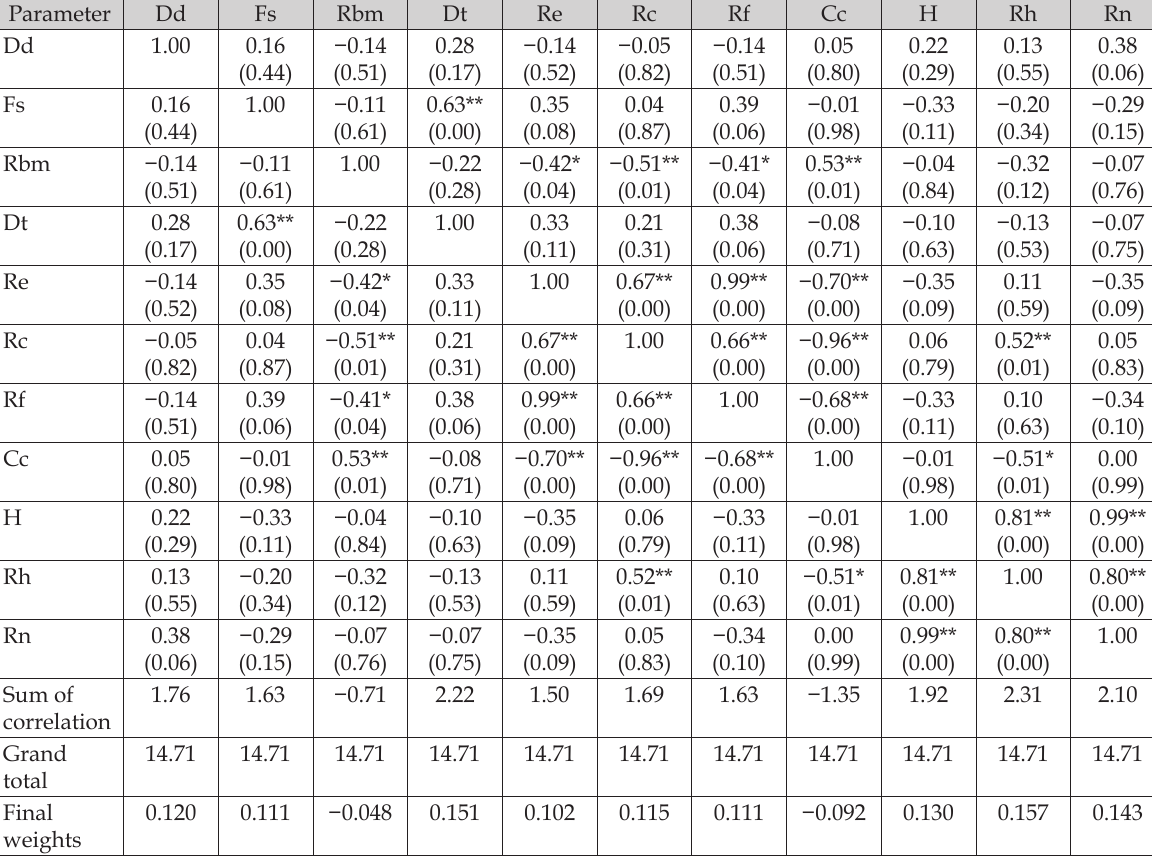
Table 6. Pearson correlation matrix of sub-watershed morphometric